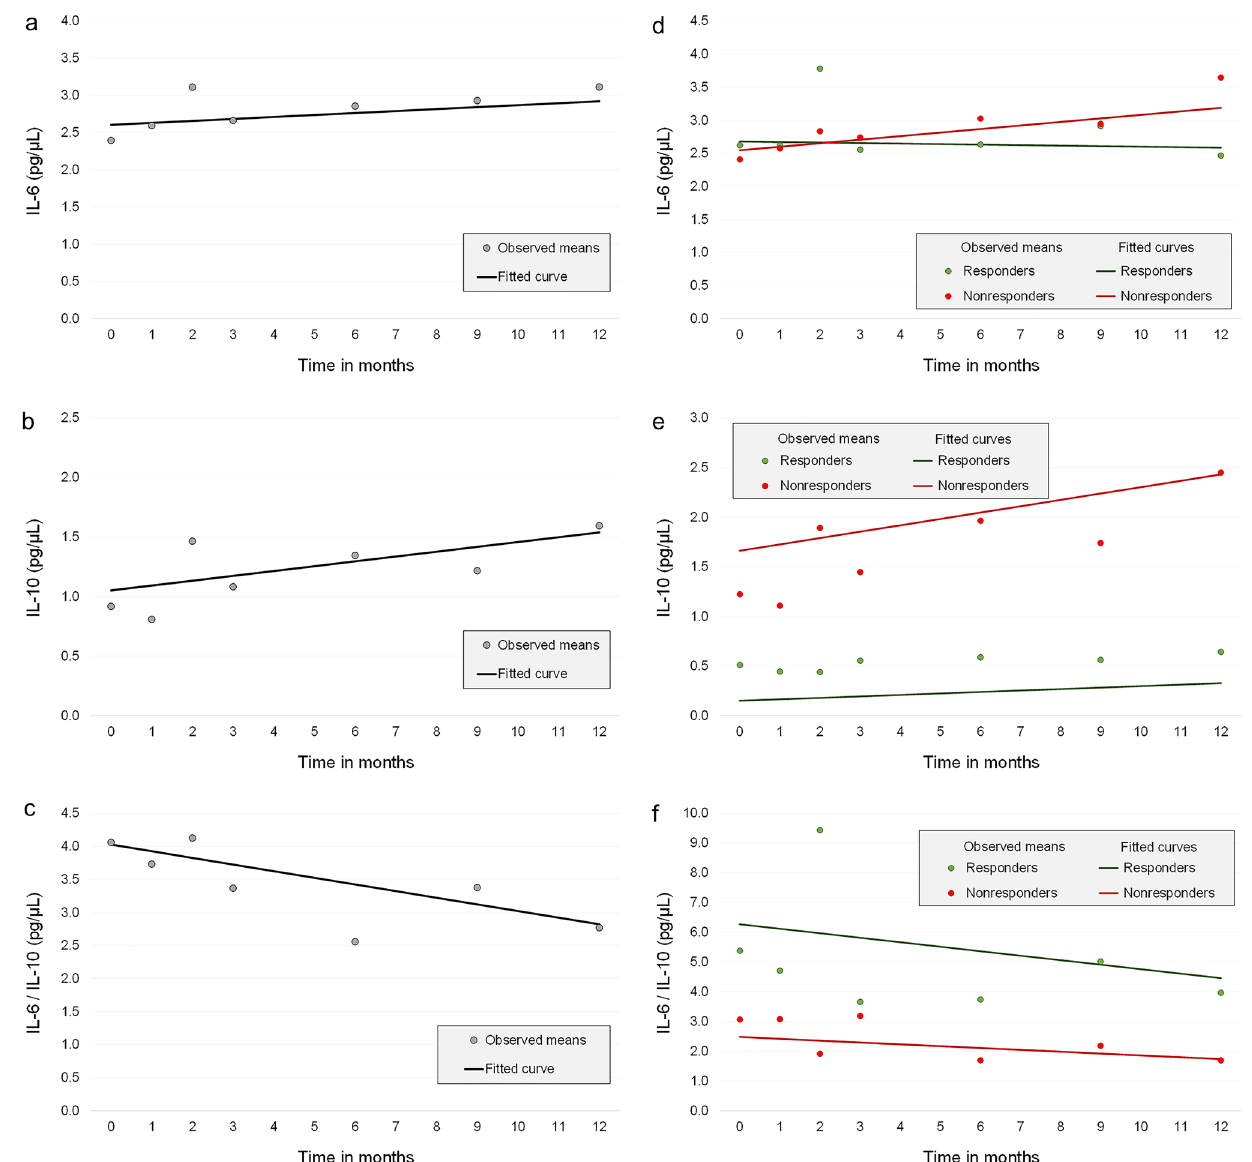
Figure 1. Observed means and fitted curves based on the GEE. Changes in cytokine levels over time in months following deep brain stimulation of the anterior nucleus of the thalamus (ANT-DBS) implantation: ( a ) interleukin-6 (IL-6) levels, ( b ) interleukin-10 (IL-10) levels, ( c ) IL-6/IL-10 ratio in the whole group and ( d ) IL-6 levels, ( e ) IL-10 levels, ( f ) IL-6/IL-10 ratio among groups based on the response to DBS. Time point 0 indicates the time of implantation (baseline or pre-DBS sample). Stata version 16.1 (StataCorp, College Station, Texas, USA) was used to prepare scatterplots and Excel (Microsoft Excel for Microsoft 365 MSO) was used to draw this